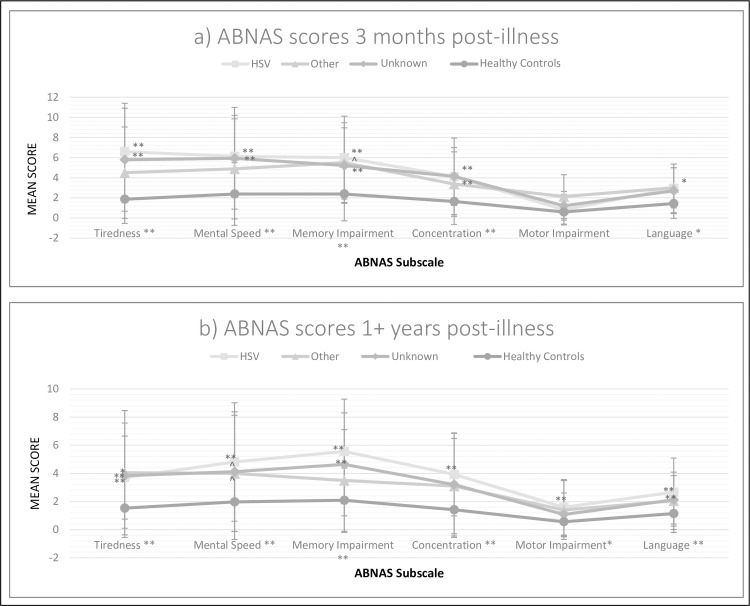
Subjective cognitive complaints for each group (ABNAS subscale scores).The error bars represent the standard deviation of the mean score within each group. (a) At the short-term assessment, a mean of 4 months post-discharge (in the short- and medium-term outcome cohort) and (b) at the long-term assessment, at least 1-year post-discharge (in the long-term outcome cohort). Notations: For main analyses of subscales (all Kruskal Wallis), significance is labelled adjacent to the subscale name along the x-axis, alpha p = 0.05, * p ≤ 0.05, ** p ≤ 0.01; For the breakdown of main analyses using Mann Whitney U post hoc, significance is labelled adjacent to data points within the figure, corrected alpha p = 0.02, * p ≤ 0.02, ** p ≤ 0.01, ^ trending significance (p = 0.03); Abbreviations: ABNAS (A-B Neuropsychological Assessment Schedule).